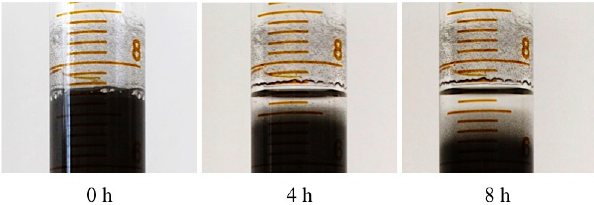
Figure 4. Particle sedimentation in PDMS that has similar viscosity but is clear only by gravity without a magnetic field.